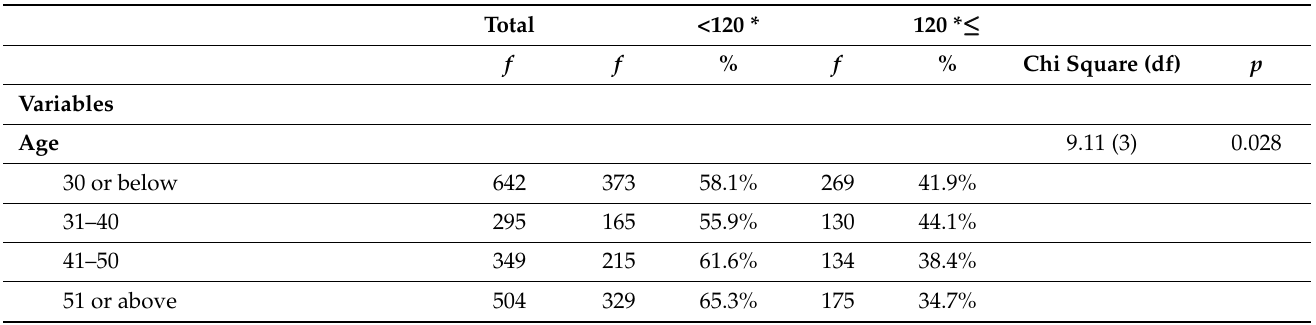
Table 4. The differences between restrictive incidents and different restrictions times (less than